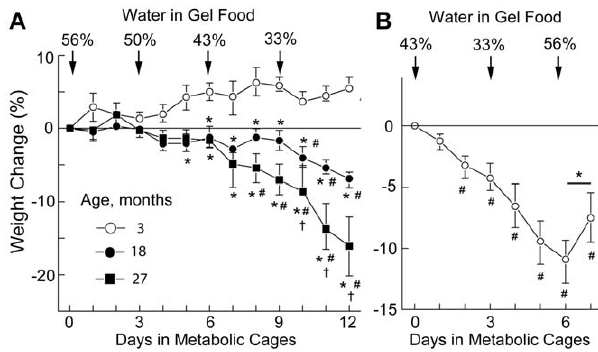
Figure 2. Analysis of hydration based on changes of body weight. A) Changes of body weight resulting from decreased water intake in mice of different ages. Data are presented as % weight change relative to the weight at the beginning of the experiment (median and IQR, n=3–4, * P , 0.05 relative to 3 month old mice; # P , 0.05 relative to 0 time; { P , 0.05 relative to 18 month old mice). 3 month old mice do not lose weight, despite decreasing water intake. 18 and 27 month old mice lose weight when water content of the gel food falls to 43% - 33%. 27 month old mice lose the most weight and are very dehydrated by the end of the experiment. B) Reversal of progressive weight loss when low water content of the gel food is increased. 16 month old mice were subjected to consecutive periods (3 days each) of 43%, then 33% water in their gel food, which caused weight loss that progressed over 6 days. On day 7 when the water content of the gel food was increased to 56%, the mice began regaining weight. This rapid onset of weight gain when water intake was increased supports our use of weight as a measure of water balance. Data are plotted as Median and IQR; n=4, ( # ) P , 0.05 relative to 0 time. (*): P=0.06 if Mann-Whitney Test (one-tailed, paired) is used, P=0.002 if Student t-test (one-tailed, paired) is used. Note: the experiments shown on panels A and B are not directly compatible